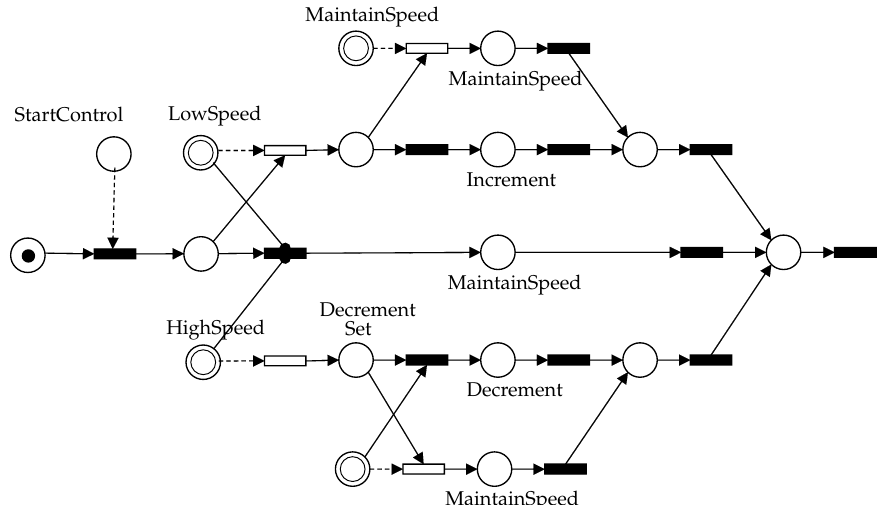
Figure 8. Example of a Speed Control HPN obtained from the blue box shown in the PFS model from Figure 7. The system used to model the HPN has horizontal transitions instead of vertical